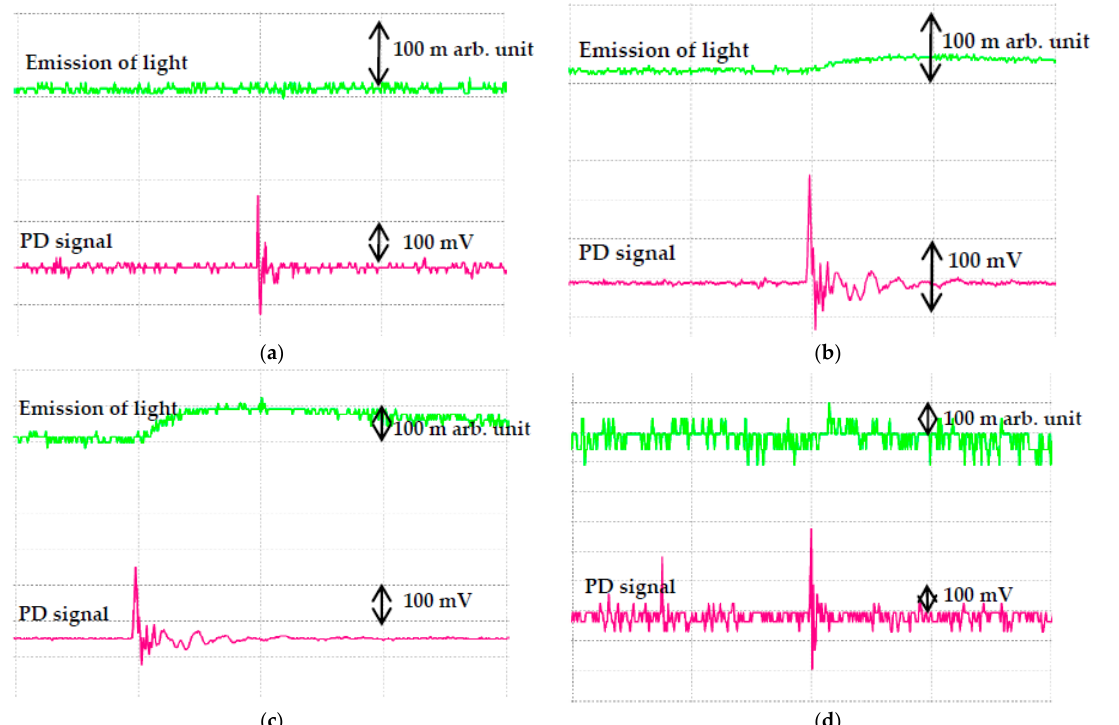
Figure 10. Emission of light signals (PMT) and PD signals (IMC) for ( a ) RBDPOA, ( b ) RBDPOB, ( c ) CO and ( d ) MO at 30 kV applied voltage.